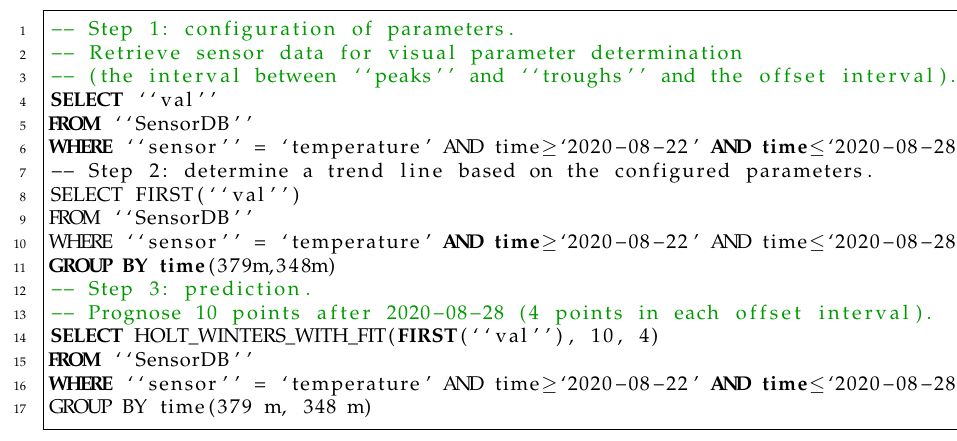
Figure 4. Time series prediction in